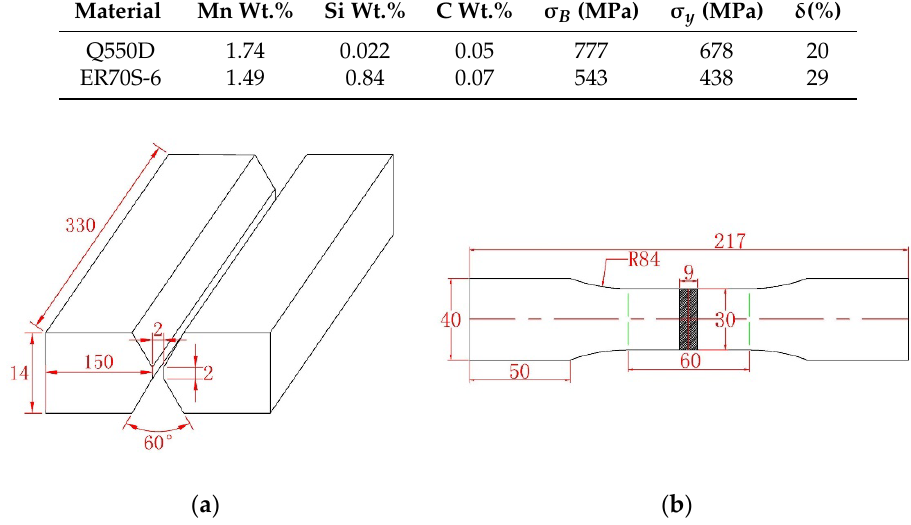
Figure 7. ( a ) Geometric parameters of the Q550 steel plate; ( b ) Geometric parameters of the fatigue specimen of welded joints. (Unit: mm).